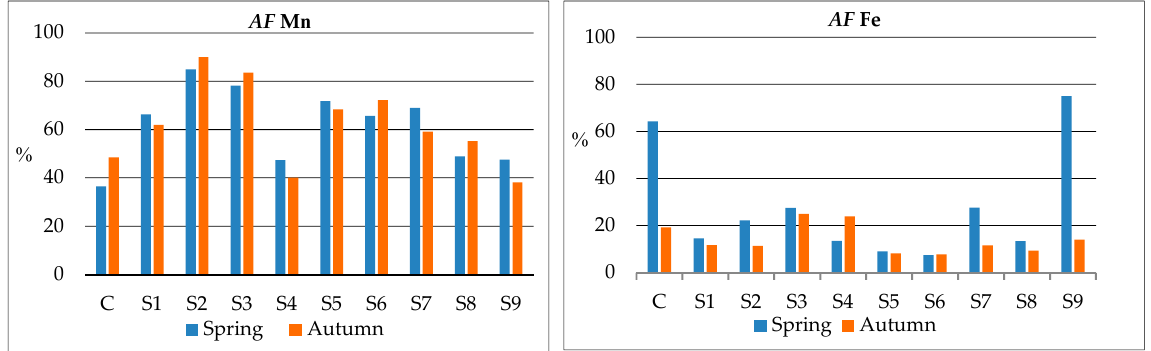
Figure 4. Availability factor AF (%) for manganese (Mn) and iron (Fe).